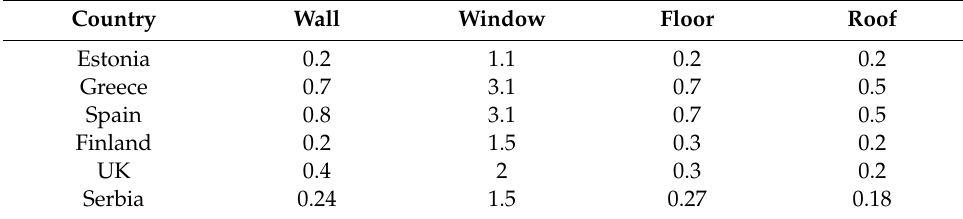
Table 1. Summary table of the U values for each country (W / m 2 K). Source.